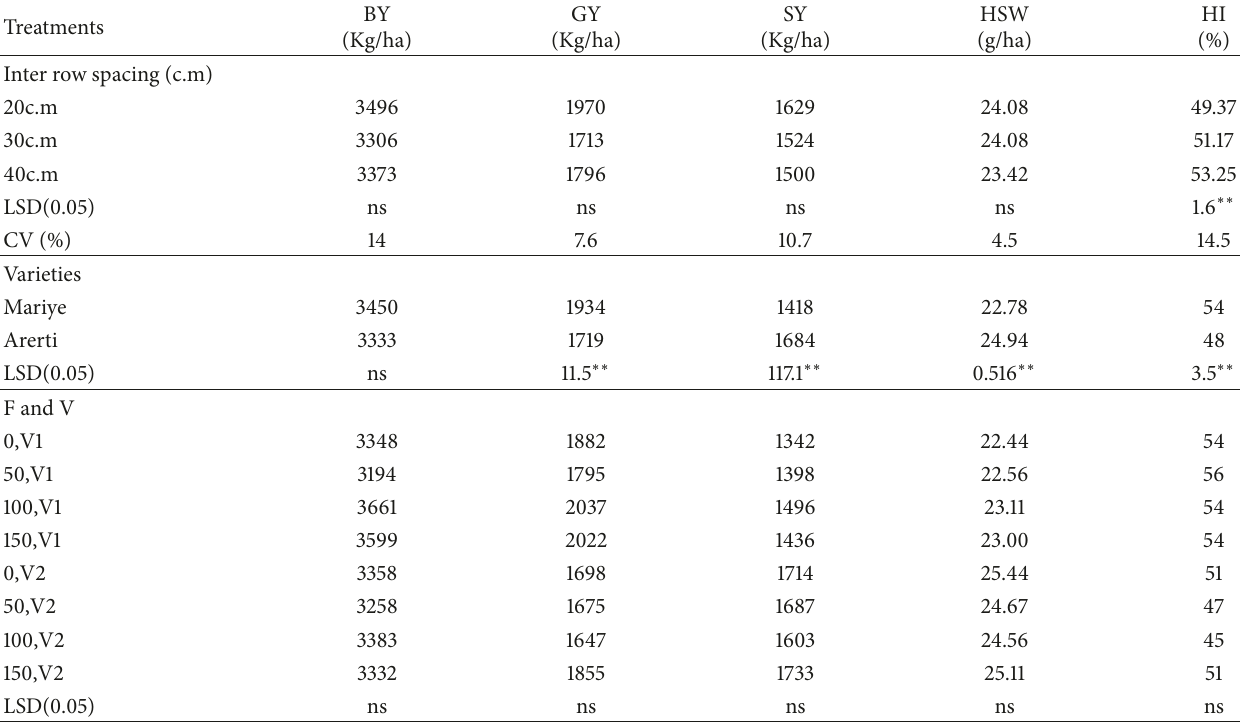
BY GY SY HSW (Kg/ha) (Kg/ha) (Kg/ha) (g/ha) (%)